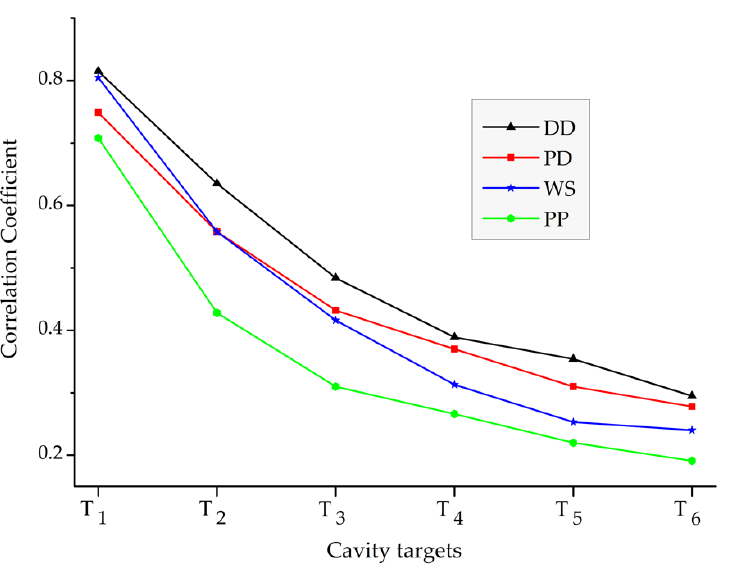
Figure 6. The statistical correlation between the inverted resistivity models and actual air-filled cavity models.